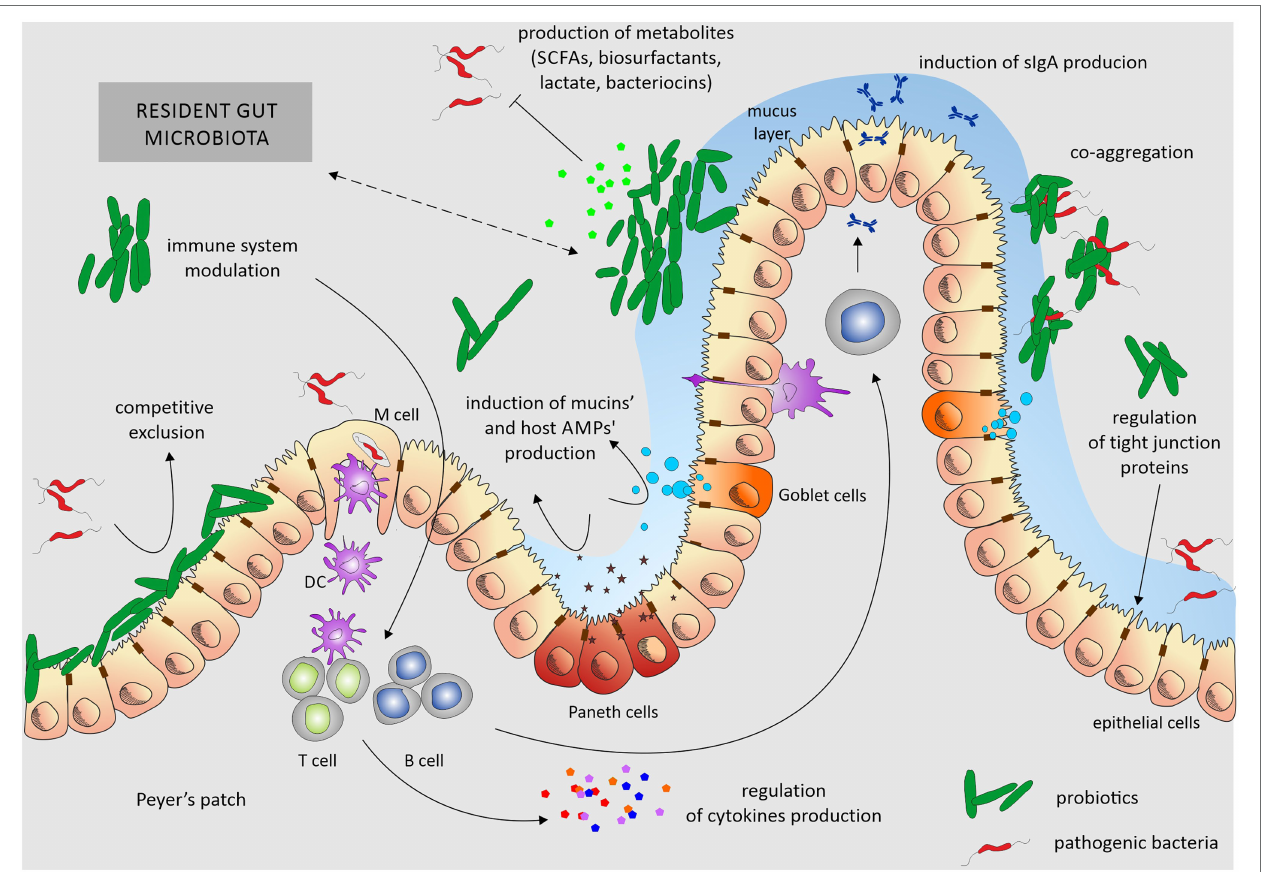
FIGURE 2 | Overview of mechanisms of probiotics’ action. Probiotics exert their beneficial effects mainly by ensuring the proper balance of the microbiota colonizing the gut. Probiotic activity depends on stabilization of the epithelial barrier, induction of mucin secretion, and aggregation skills. By adhering to enterocytes, they reduce the opportunity for the colonization of this ecological niche by pathogenic bacteria. They also produce various, not always fully characterized, metabolites that inhibit the growth of pathogens. Additionally, they modulate the host immune system. Probiotics influence the gut through one or a combination of these mechanisms. Dotted arrow underlines the interplay between the host microbiota and probiotic strains and nature of these interactions can be both – positive, negative, depending on the composition of resident gut microbiota and used probiotic. DC, dendritic